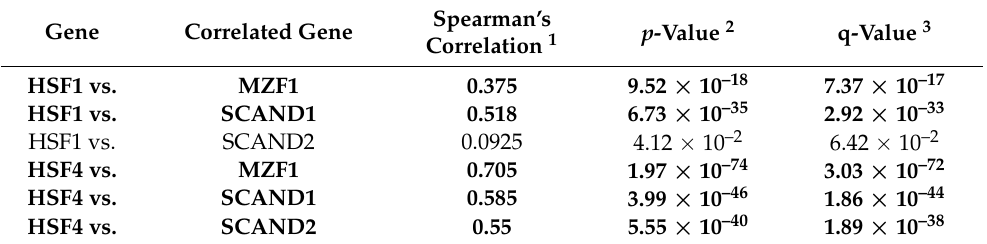
Table 2. Co-expression correlation between HSFs , MZF1 , and SCANDs in prostate adenocarcinomas. Gene Correlated Gene HSF1